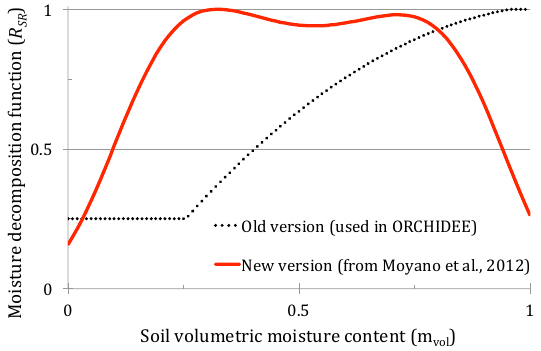
Figure 4. Moisture decomposition function used in ORCHIDEE compared to the one suggested by Moyano et al.